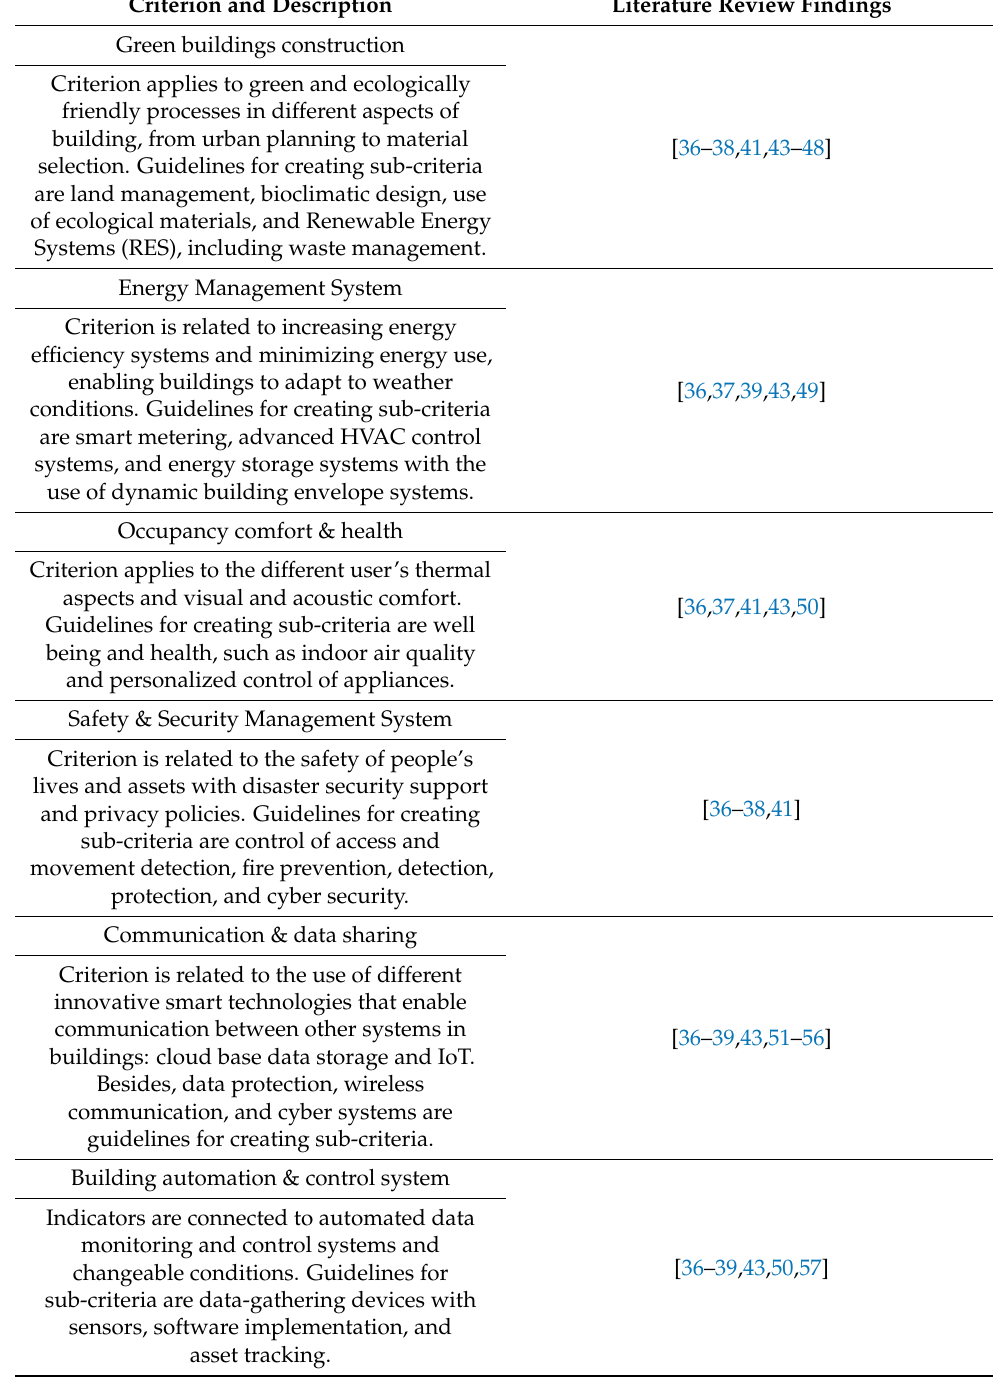
Table 1. Outline of the evaluation criteria for “smart”